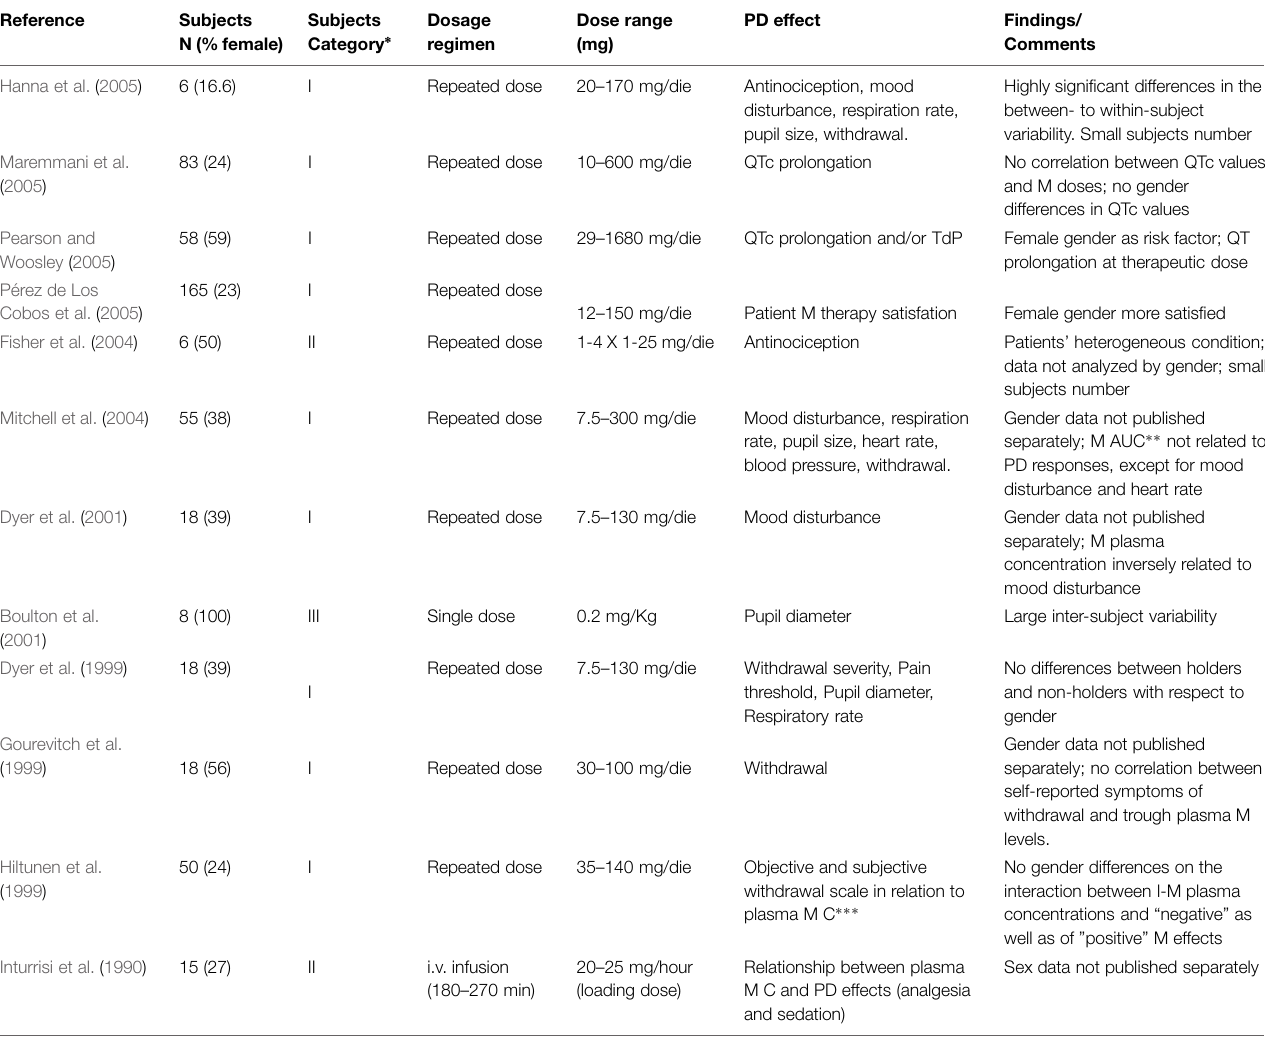
TABLE 2 | Methadone (M) PK/PD relationship